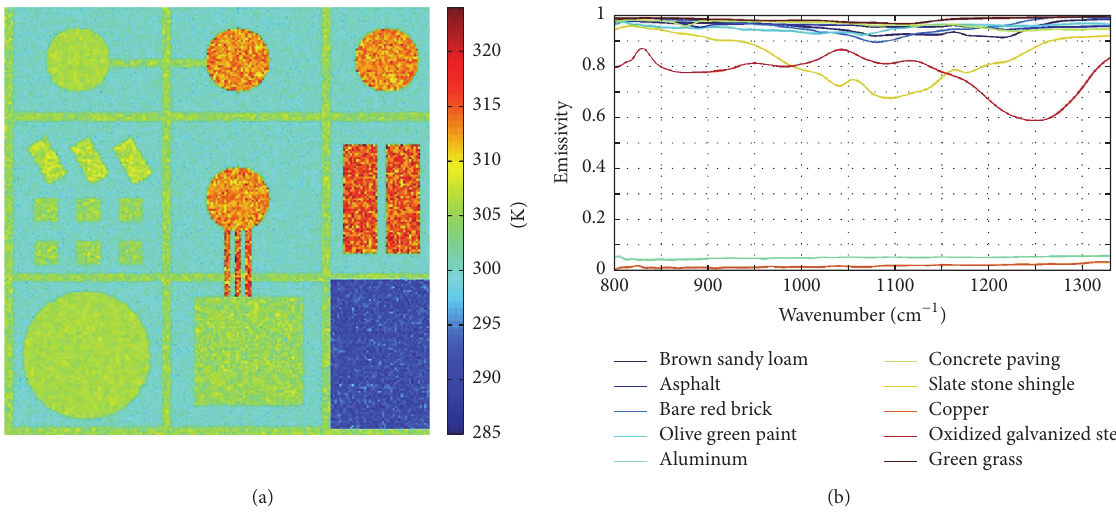
Figure 2: Ground parameters simulation. (a) Ground temperature map. (b) Emissivity spectra of materials present in the synthetic